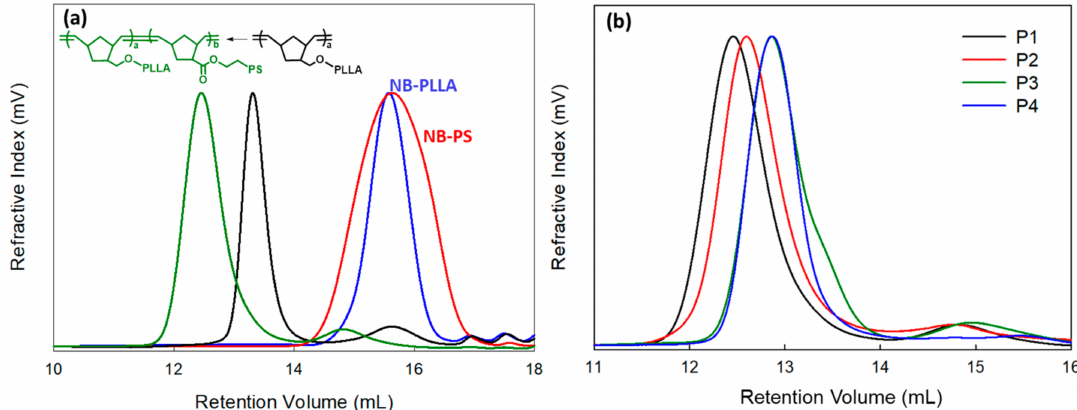
Figure 1. SEC traces: ( a ) NB-PLLA 3.68k (blue trace), NB-PS 3.28k (red trace), the first block brush homopolymer (black trace), and the final BBCP (P1) (green trace) and ( b ) BBCPs with various PLLA volume